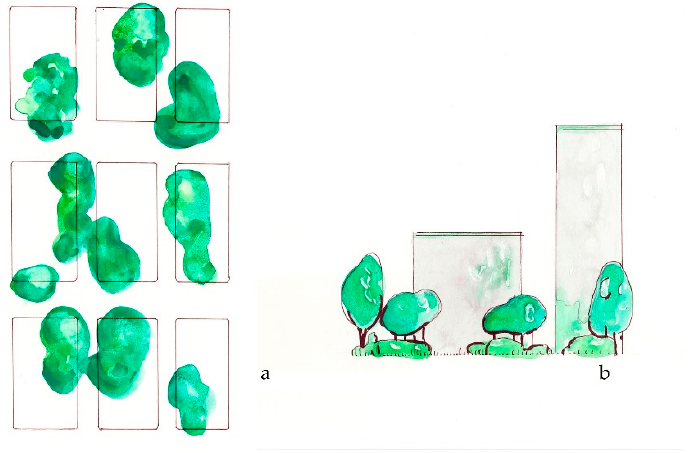
Figure 9. Optimize green infrastructure suggests that canopy cover, planting spaces, and pervious surfaces could be optimized within a neighborhood to maximize health and climate co-benefits. ( a ) Plan view of combined green spaces; ( b ) Sketch elevation of green spaces across blocks.